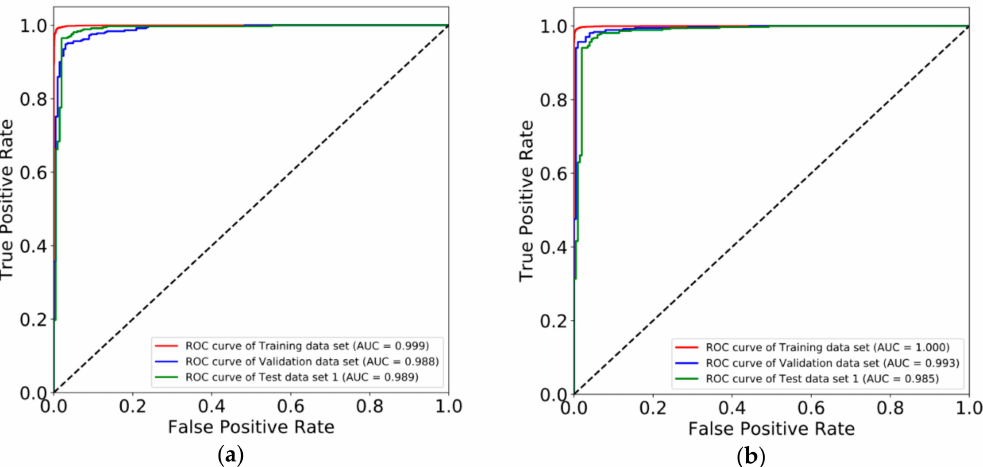
Figure 2. ROC curves of the three data sets. ( a ) ROC curves of CpG methylation data. ( b ) ROC curves of promoter methylation data. ROC curves: Receiver operating characteristic